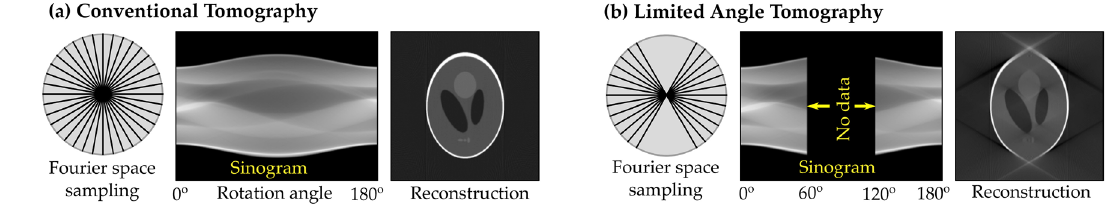
Figure 1. Comparison of the conventional and limited angle tomography